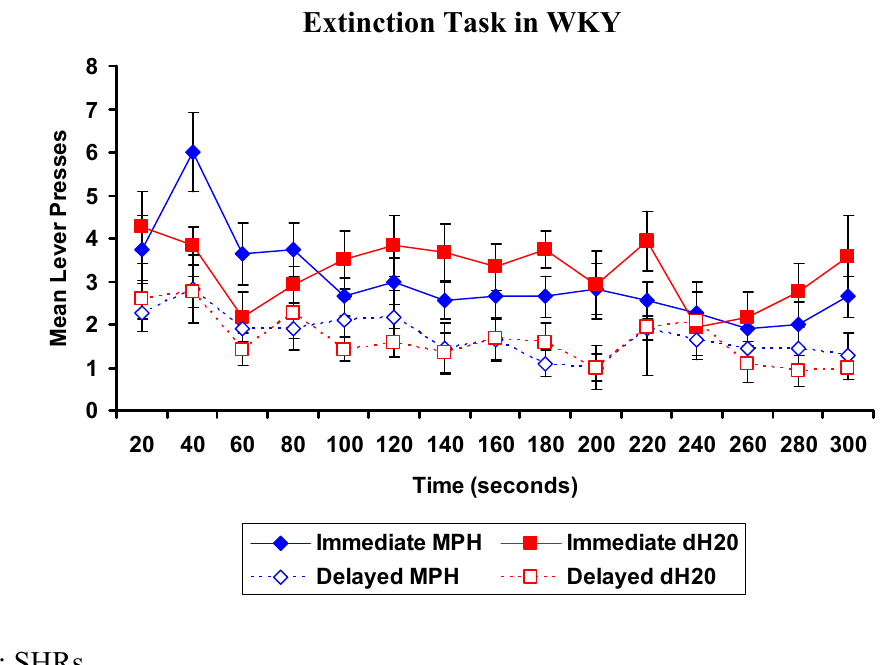
Figure 6. WKY rats: Mean (±SEM) number of presses on the immediate (closed) and delayed (open) levers in consecutive 20 s intervals for rats previously exposed to 4 weeks of oral methylphenidate (MPH, 2 × 2 mg/kg/day; blue diamond; n = 11) or distilled water (dH O; red squares; n = 12), during the extinction task. There was a significant lever by 2 time by treatment interaction, p = 0.039. The extinction task was conducted 48 h following the final DRT